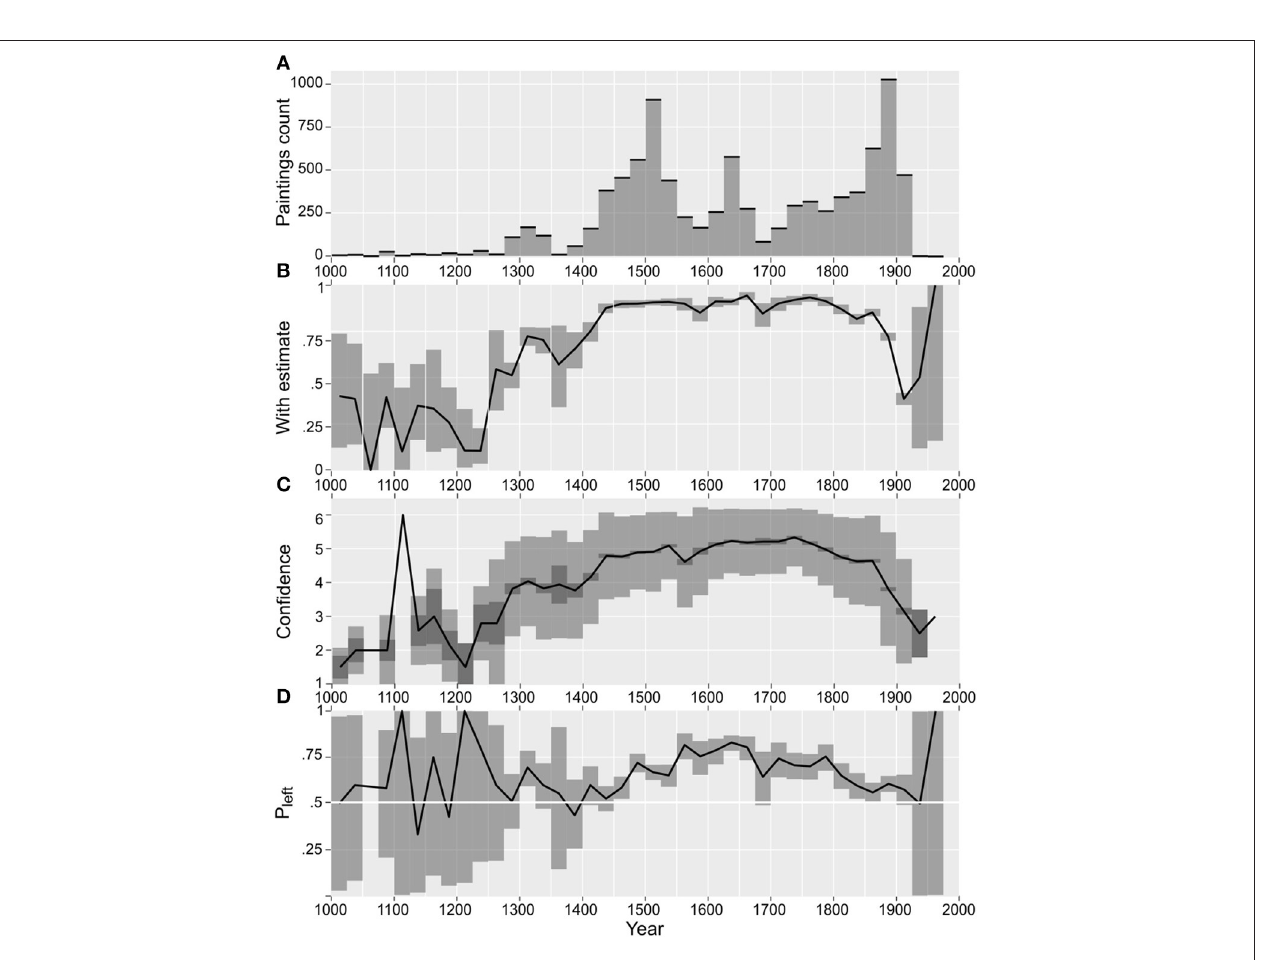
Frontiers in Psychology | www.frontiersin.org